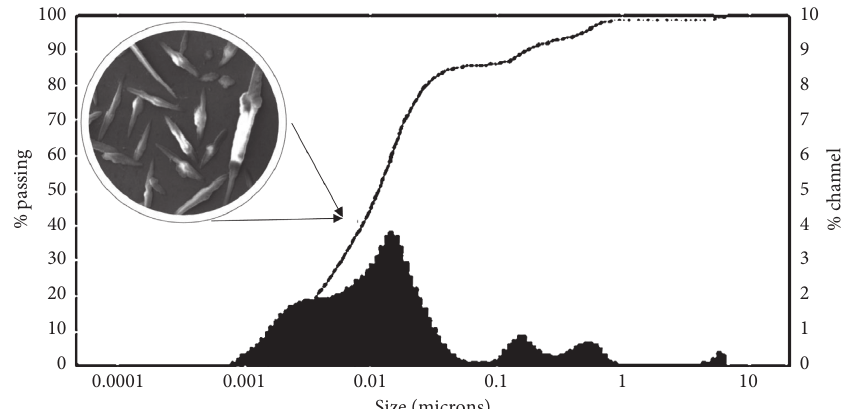
Figure 3: Particle size distribution of ZnO NPs- M. oleifera using dynamic light scattering (DLS)